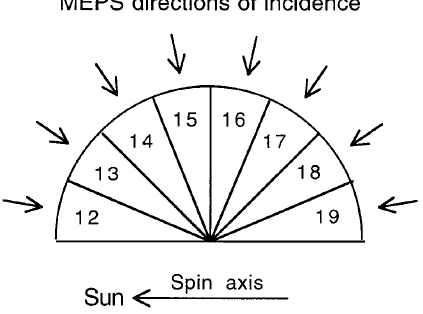
Fig. 2. Viewing directions for the di(cid:128)erent detectors of MEPS